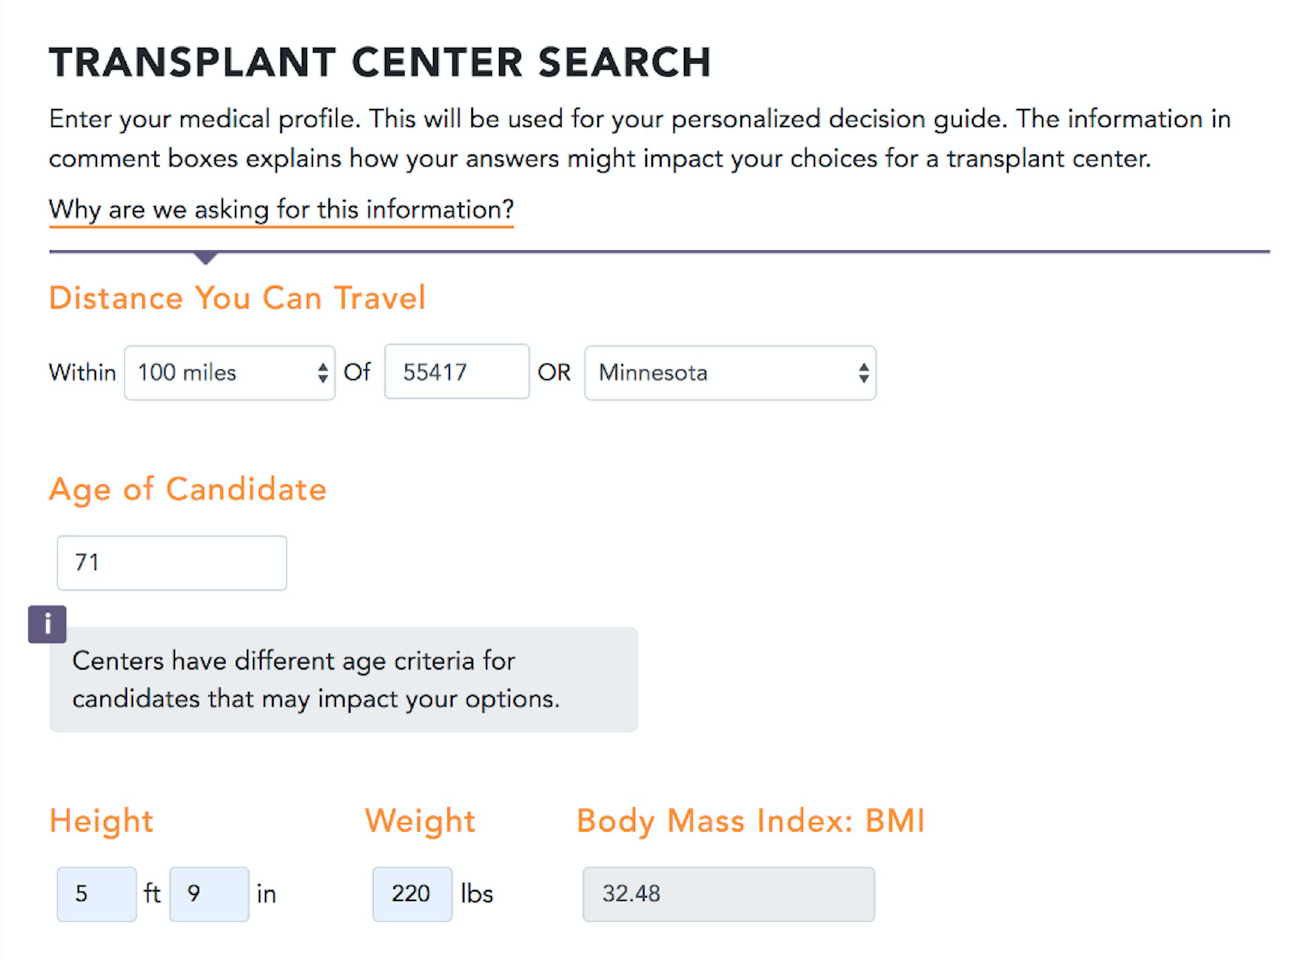
Fig 3. Development website screenshot of a portion of the data entry page: Final iteration. The characteristics shown represent criteria that may impact if a patient is accepted or declined at a center. A pop-up message appears if a user enters data that is outside of typical criteria, such as age greater than 70.